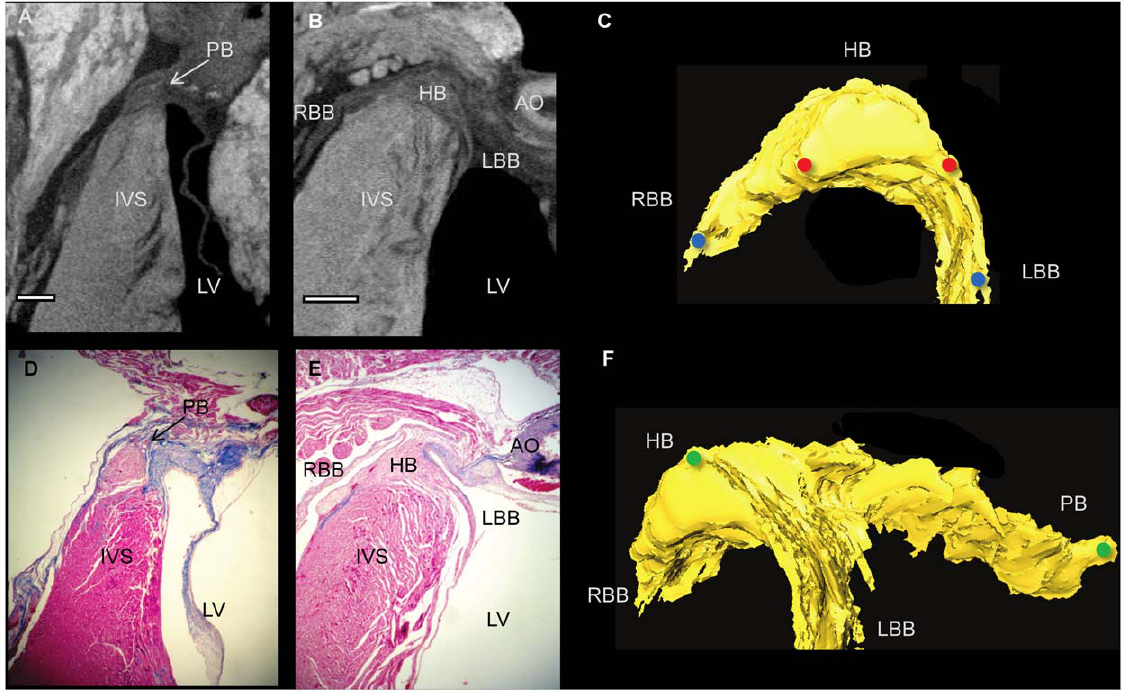
Figure 2. The atrioventricular conduction axis in rat. Longitudinal micro-CT images showing the penetrating bundle and His bundle in rat hearts stained with 7.5% (A) and 3.75% (B) I 2 KI for 2 days. Corresponding histological sections stained with Masson Trichrome (D,E). Segmented 3D surfaces of atrioventricular conduction axis, showing the anteriorly positioned His bundle (C) and its lateral aspect (F). Distance between red dots- 0.6 mm, blue dots- 1.3 mm, green dots- 2.4 mm. AO- aorta, HB- His bundle, IVC- interventricular septum, LBB- left bundle branch, LV- Left ventricle, PB-penetrating bundle, RBB-right bundle branch. (Scale bar represents 0.5 mm).